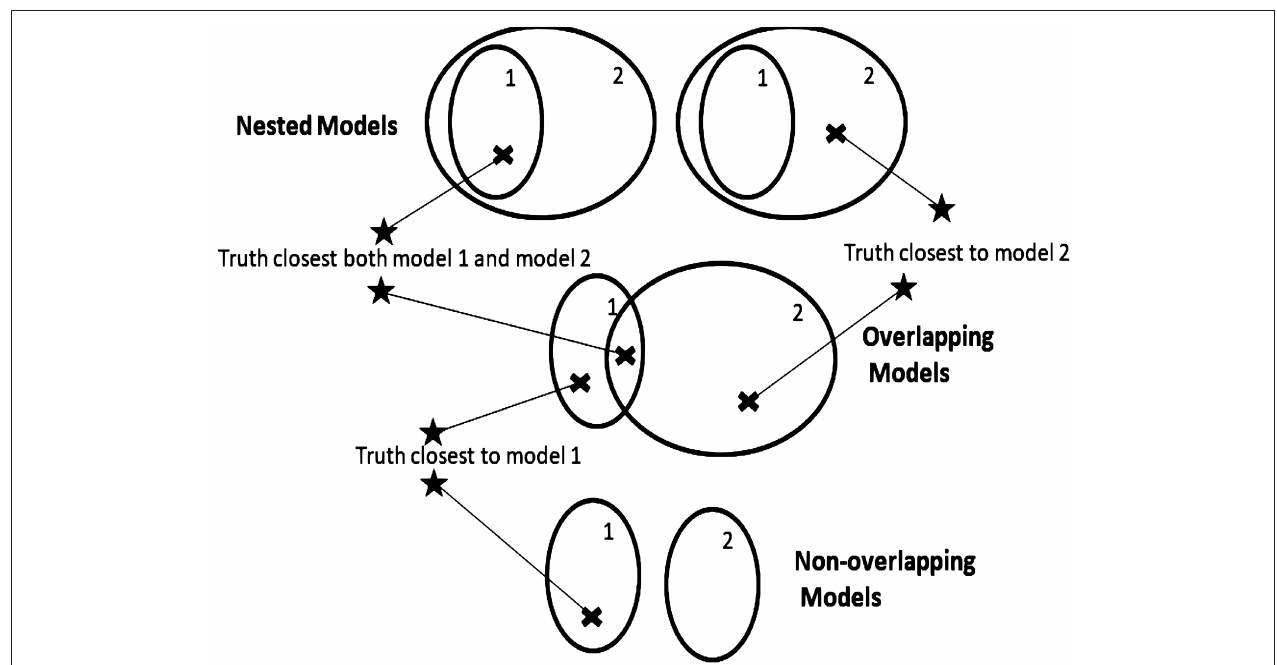
FIGURE 2 | Model topologies when models are misspecified. Regions represent parameter spaces. Star represents the true model that generated the data. Exes represent the point in the parameter space covered by the model set closest to the true generating process.